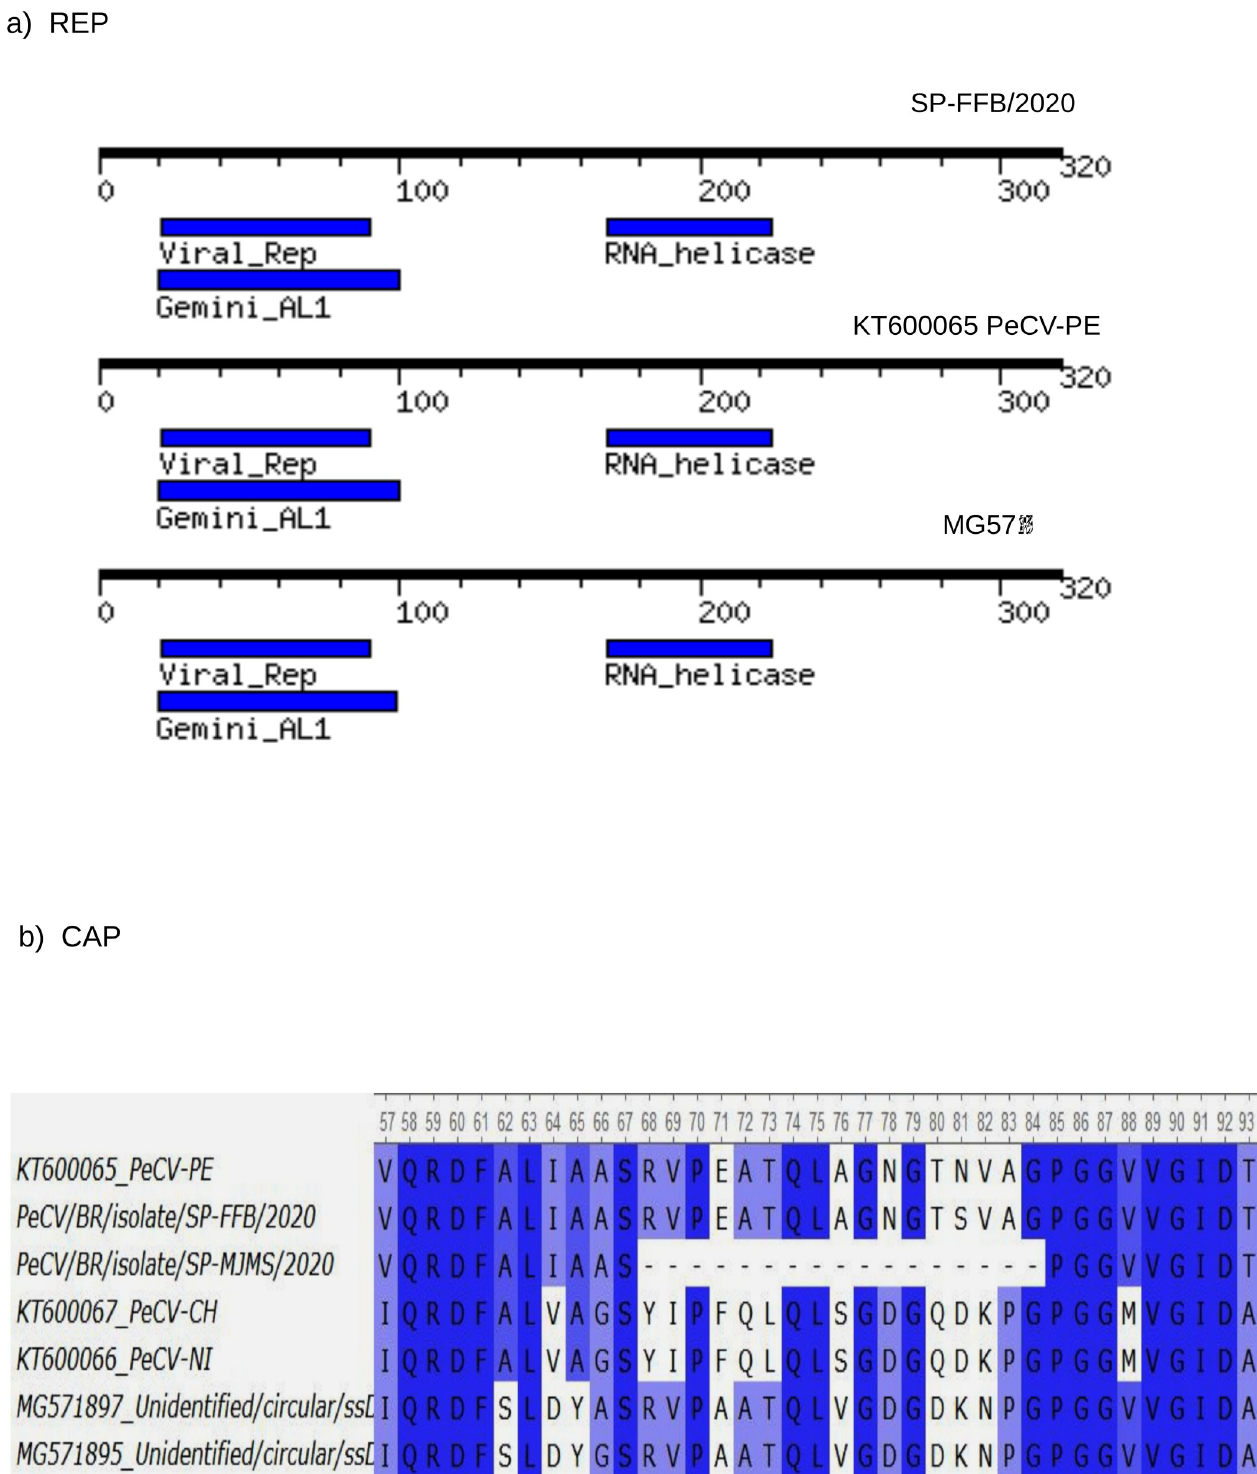
Fig 2. Characteristics of REP and CAP of PeCV. ( a ) The diagram represents the REP region of PeCV (black line) and the main motifs detected by motif finder analysis (blue areas) using pfam data base. Motifs were determined online by the server MotifFinder (https://www.genome.jp/tools/motif/) b) Amino acid alignment of the CAP region of PeCV. Residues in dark blue are those conserved, sites with some variations are indicated by light blue and white. Dashes indicate gaps in the SP-MJMS/2020 sequences.